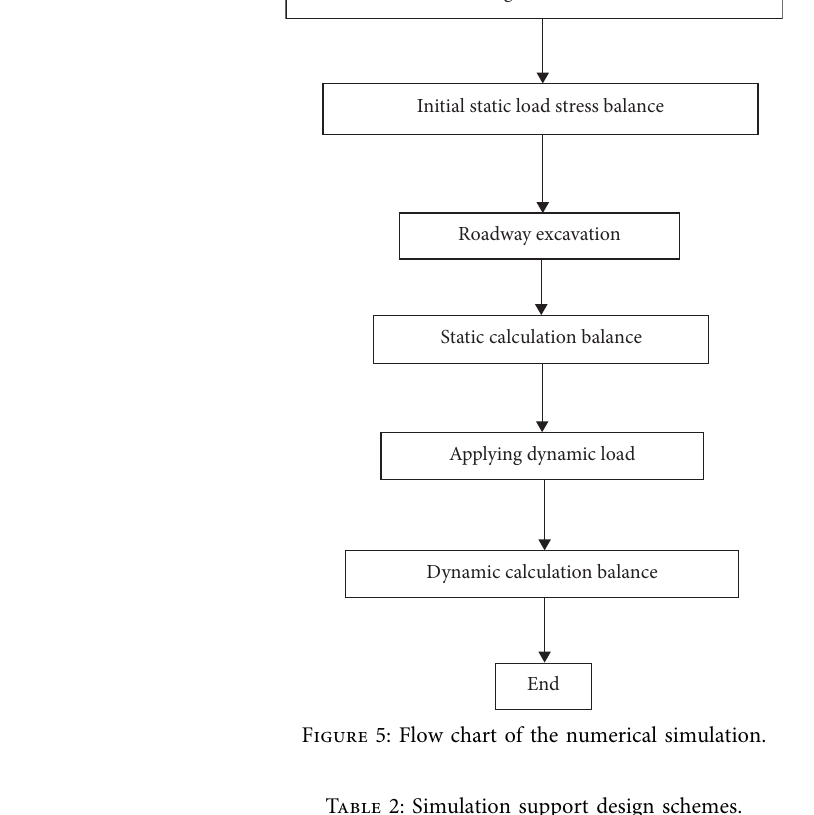
and Design L 1 2